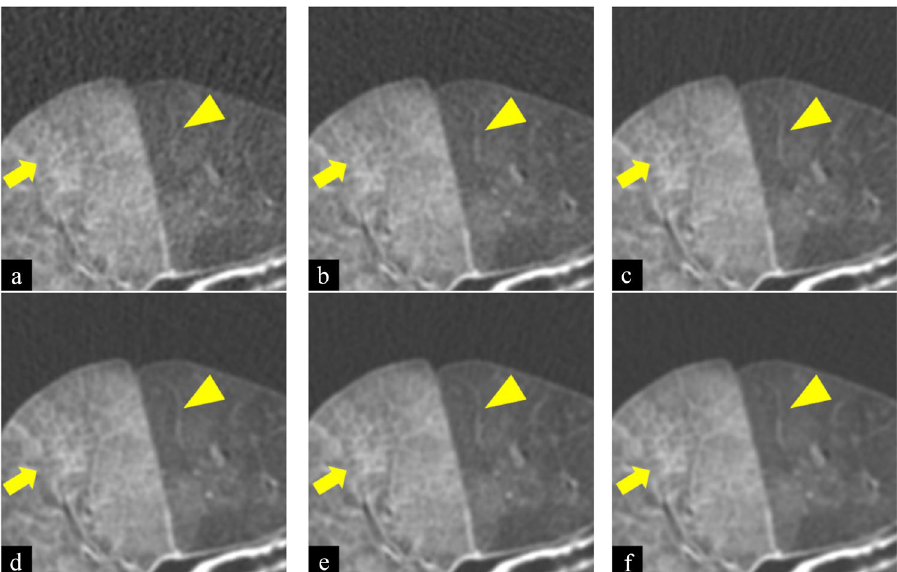
Figure 1. Images of filtered back projection (FBP) of cadaveric lung (diffuse alveolar hemorrhage) at 10 ( a ), 25 ( b ), 50 ( c ), 75 ( d ), 100 ( e ), and 175mAs ( f ). Window width was 1200 and Window level was − 700 (Hounsfield Unit). Scan field of view was 20 cm. The length and width of each figure was 6.5 cm. As tube current–time product decreased, the shape of the small vessel (arrowhead) and reticulation (arrow) became obscured. In addition, noise and streak artifacts increased.